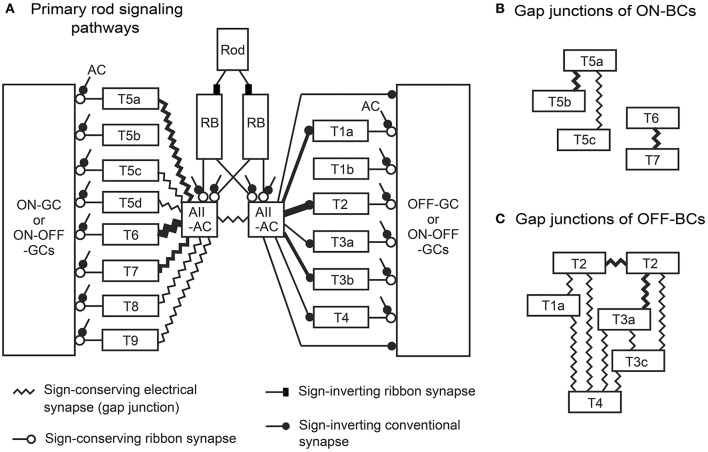
Model of the primary rod signaling pathways from a rod photoreceptor to ganglion cells via rod bipolar (RB) cells, AII amacrine cells, and all types of (cone) bipolar cells. (A) Each AII amacrine cell (AII-AC) had gap junctions with ON (cone) bipolar cells and conventional synapses with OFF (cone) bipolar cells, although only half are depicted. (B) Gap junctions between different types of ON bipolar cells (ON-BCs), which are connected to a network of AII-AC–ON bipolar cell gap junctions. (C) A network of gap junctions among OFF bipolar cells (OFF-BCs).